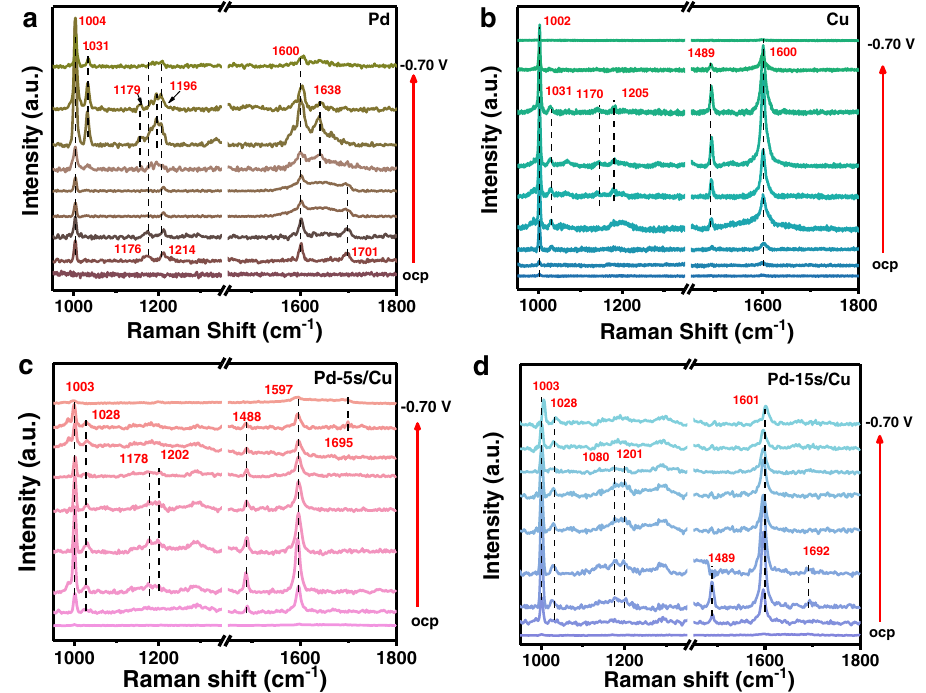
Fig. 4 | RamanspectroscopicinvestigationofPd/Cu catalysts. In situ Ramanspectraof benzaldehyde electroreductionover a Pd, b Cu, c Pd-5s/Cu, and d Pd-15s/Cu in 0.1M KOH electrolyte with 40mmolL − 1